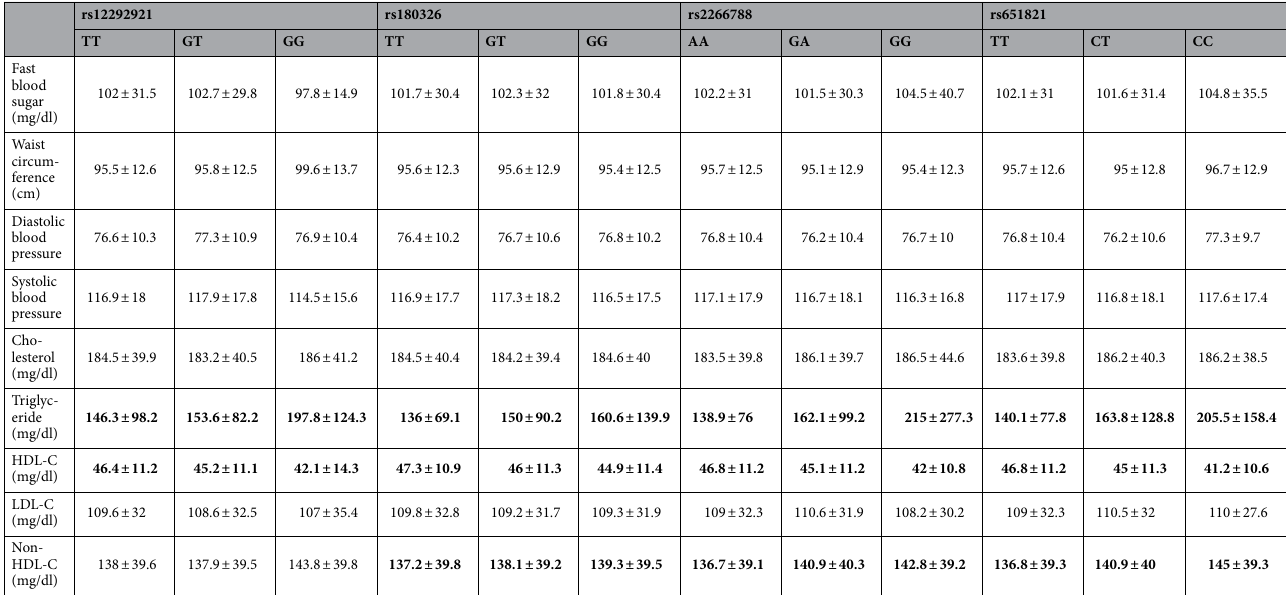
Table 5. Single SNPs association analyses for metabolic components (mean ± SD). Bold values: p-values of between genotype groups analysis were significant (p <